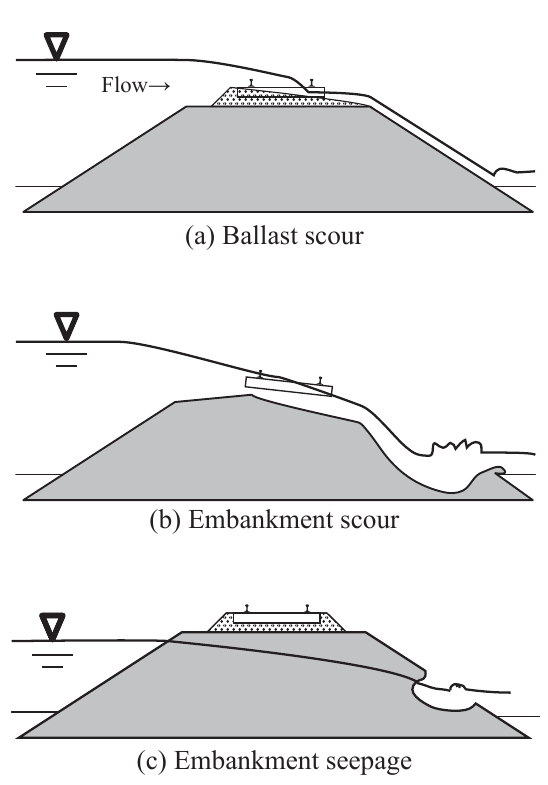
Figure 2. Railway embankment damage types.